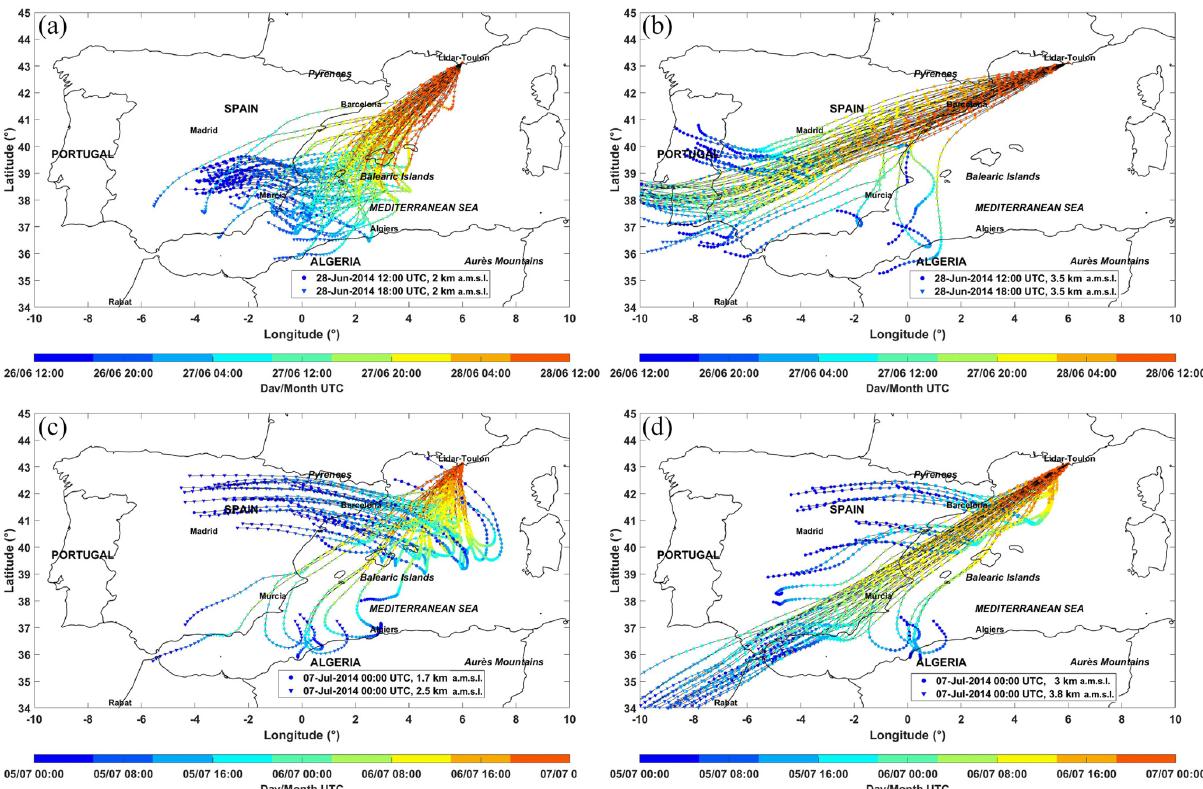
Figure 10. 2-day back trajectories from the French Riviera (Toulon; 43.13556 ◦ N, 6.00944 ◦ E). The altitudes of the end locations of the air mass trajectories are in the main pollution plumes detected by the ground-based N 2 -Raman lidar on (a) 28 June 2014 for an end location of 2km, (b) 28 June 2014 for an end location of 3.5km, (c) 7 July 2014 for end locations of 1.7 and 2.5km, and (d) 7 July 2014 for end locations of 3 and 3.8km. The HYSPLIT model worked in its ensemble mode, i.e., 27 back trajectories computed for each end